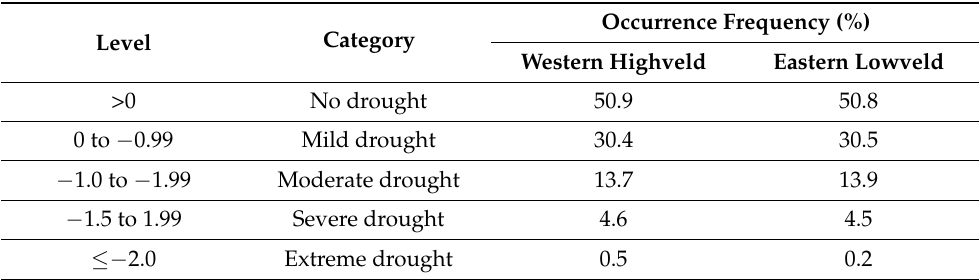
Table 7. Drought frequency in western highveld and eastern lowveld of Mopani District